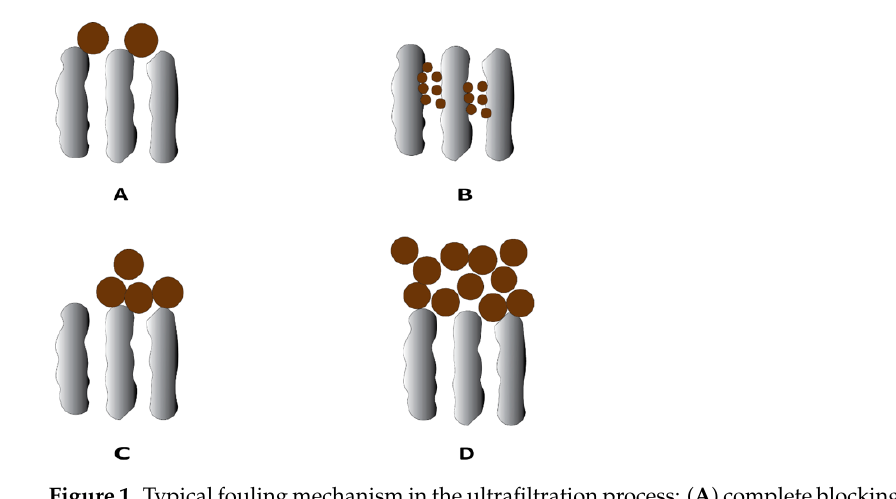
Figure 1. Typical fouling mechanism in the ultrafiltration process: ( A ) complete blocking, ( B ) standard blocking, ( C ) intermediate blocking, and ( D ) cake layer formation.